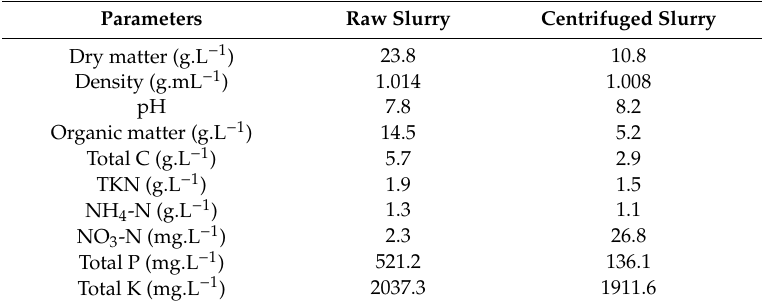
Table 6. Pig slurry characteristics (plants take up nitrogen in the form of NO 3 –N (nitrate) or NH 4 –N (ammonium); TKN, total Kjeldahl